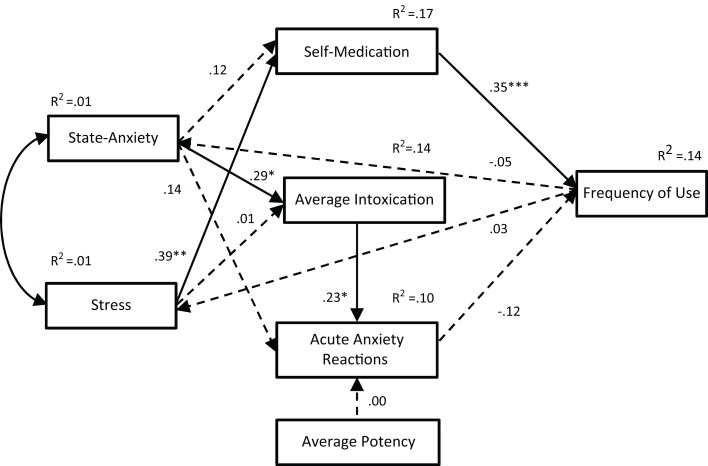
Path analysis of Model 2. With the exception of noted R2 values, all values are standardized regression weights (β), dashed lines indicate non-significant associations. Model fit: χ2(9) = 13.23, p = 0.152; TLI = 0.924; CFI = 0.967; RMSEA = 0.070 (0.000, 0.146). *p < 0.05, **p < 0.01, ***p < 0.001.